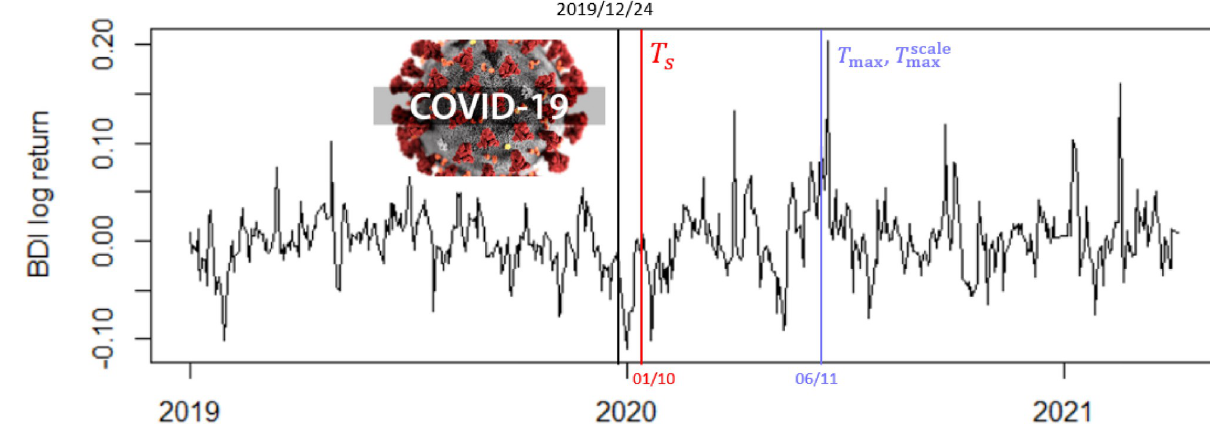
Fig 13. Change point of BDI: COVID-19